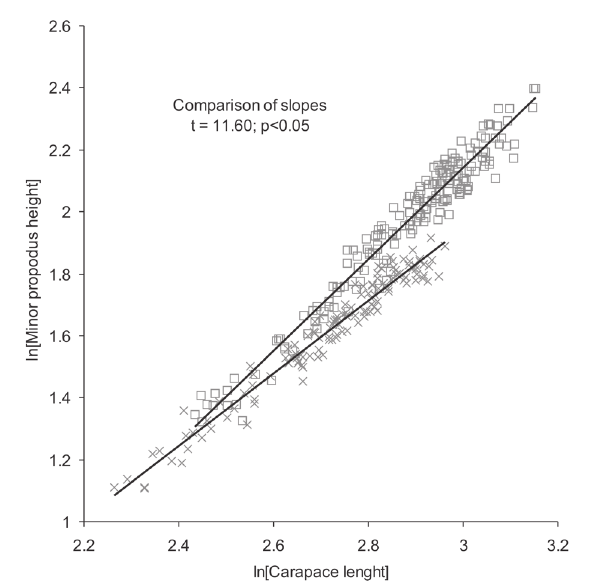
Figure 5. Aegla castro . Sexual dimorphism in minor chela propodus height. Squares = morphotype I adult males; X = adult females. Corresponding regression equations in Figure 1 (C and D). Other chelae dimensions exhibited very similar